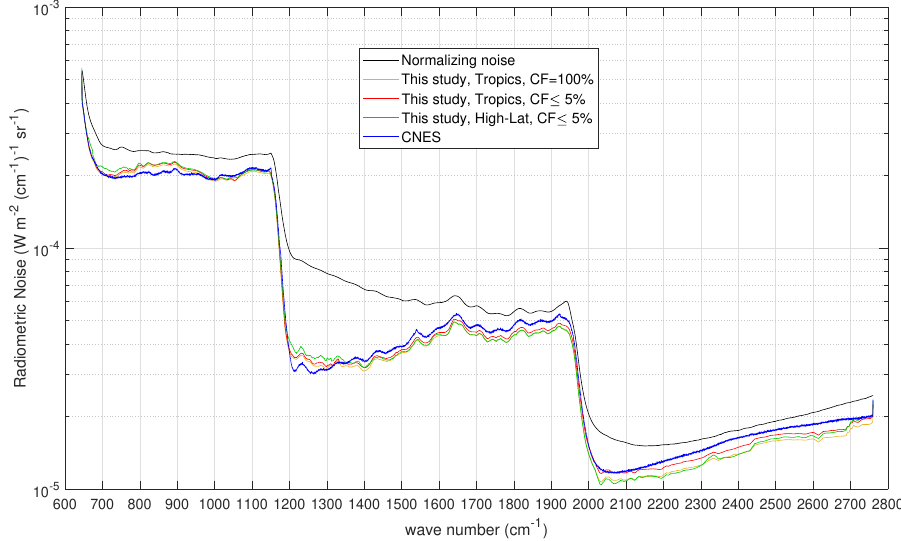
Figure 6. Results for the radiometric noise for the IASI-C instrument. The figure also shows the noise used for normalization and the nominal radiometric noise according to the CNES release